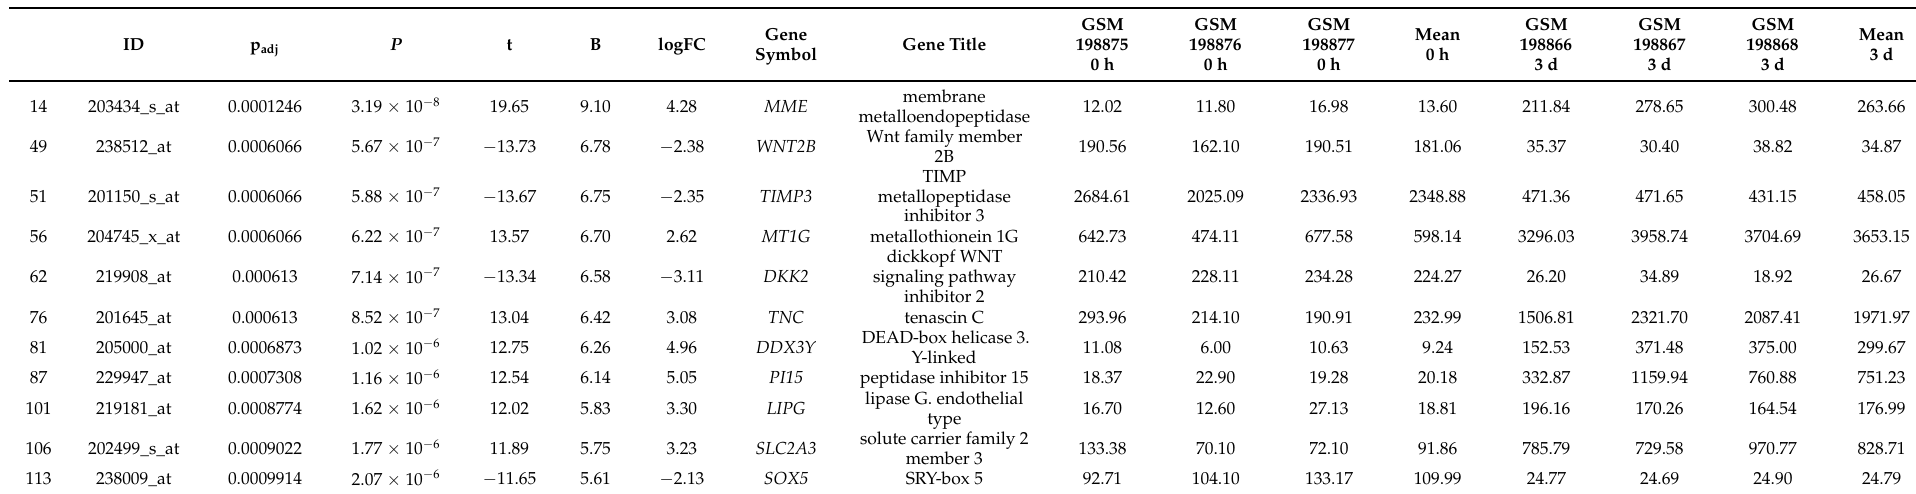
Table 2. Selected early burn-response genes, including their rank based on FDR (compare with heatmap Figure